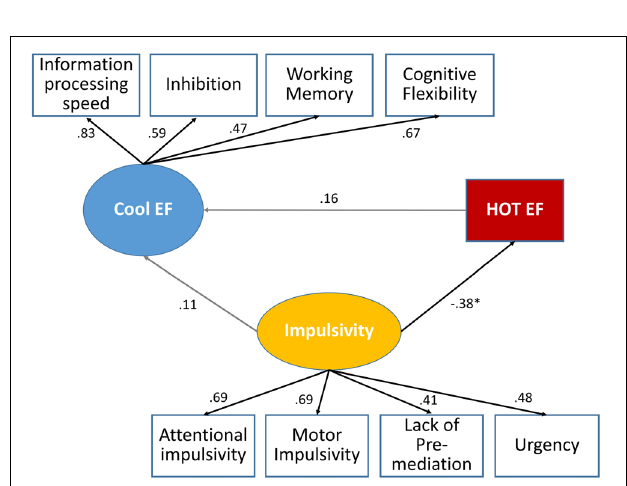
FIGURE 7 | Proposed causal paths of Hot and Cool EF and Impulsivity (standardized solution) for all athletes ( n =